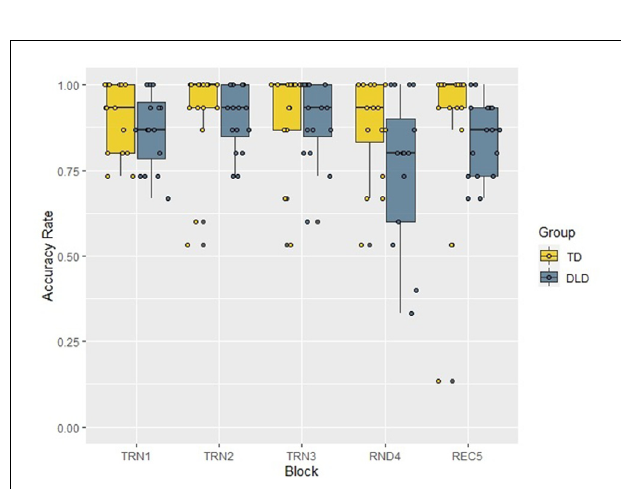
FIGURE 6 | Median RTs by Block and Group in the visual non-verbal target detection task. TD, typically developing children; DLD, children with Developmental language disorder; TRN1, First training block; TRN2, Second training block; TRN3, Third training block; RND4, Random block with disrupted structure; REC5, Recovery block.